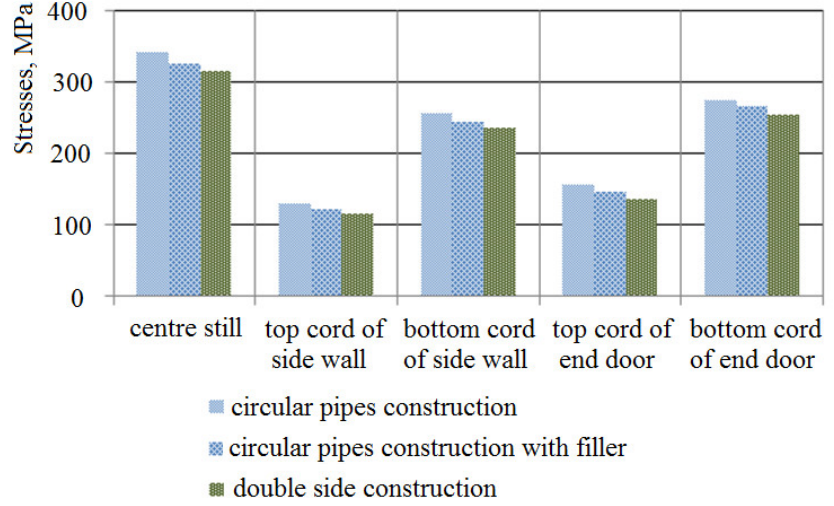
Figure 4. Stresses on components of the bearing structure of a circular-piped wagon.